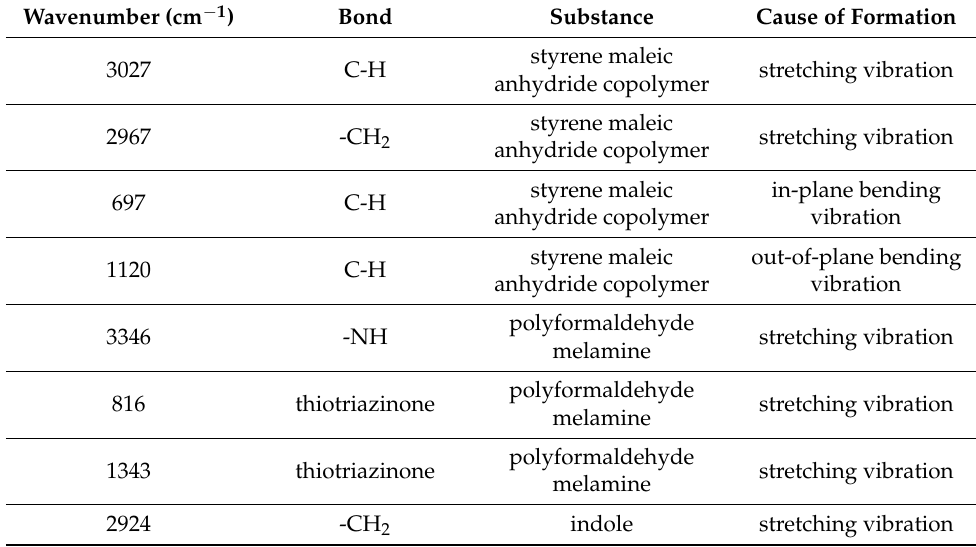
Table 6. Characteristic peaks in the FTIR image.